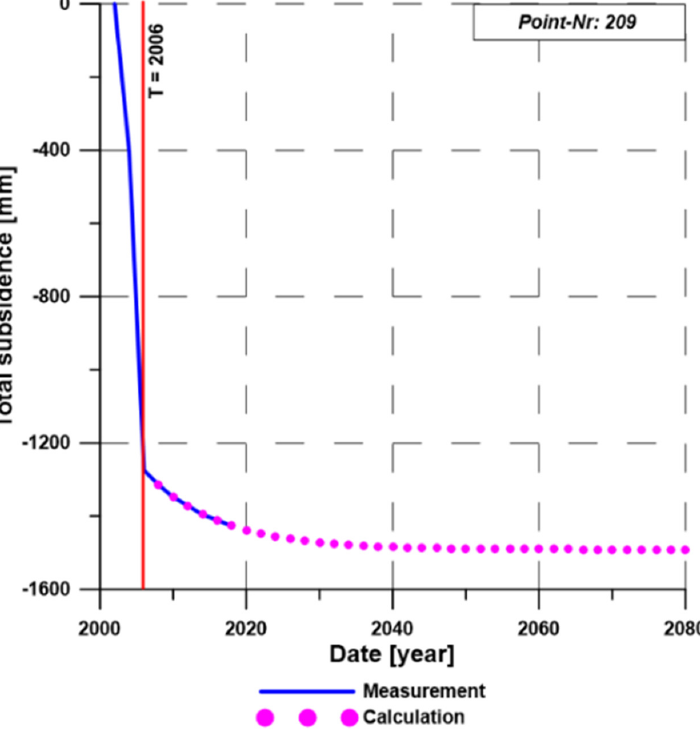
Figure 9. The course of subsidence until 2018 and the prediction of residual subsidence for the point no. 209.